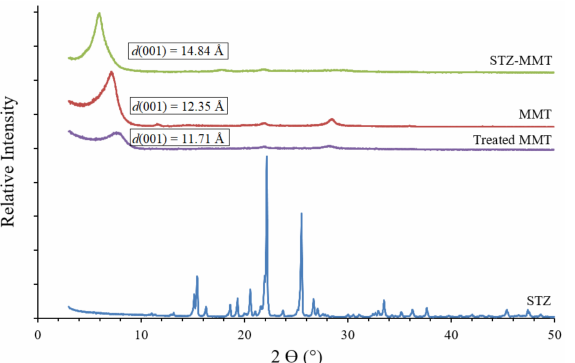
Figure 2. Powder X-ray diffraction patterns of the oriented aggregate of the different samples